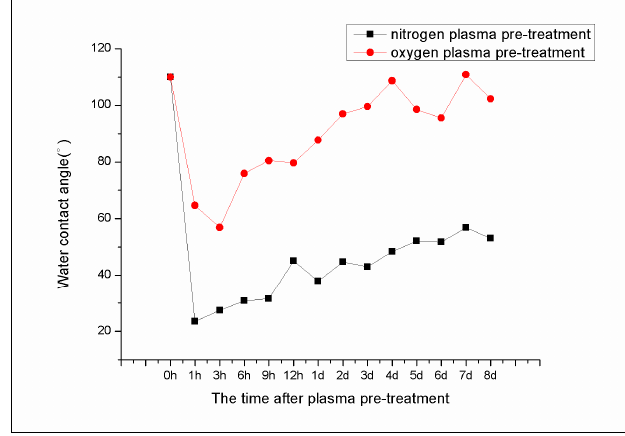
Figure 1. Contact angle of treated nitrogen plasma and treated oxygen plasma.